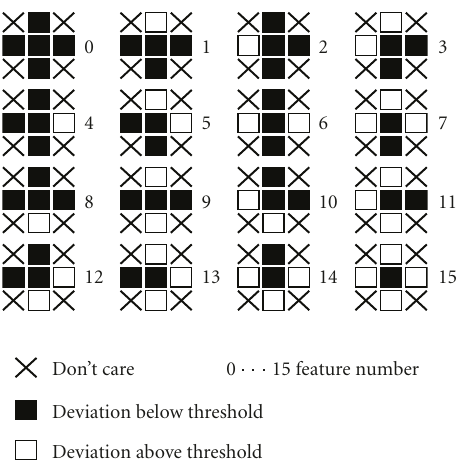
Figure 2: Possible N 4 neighborhood